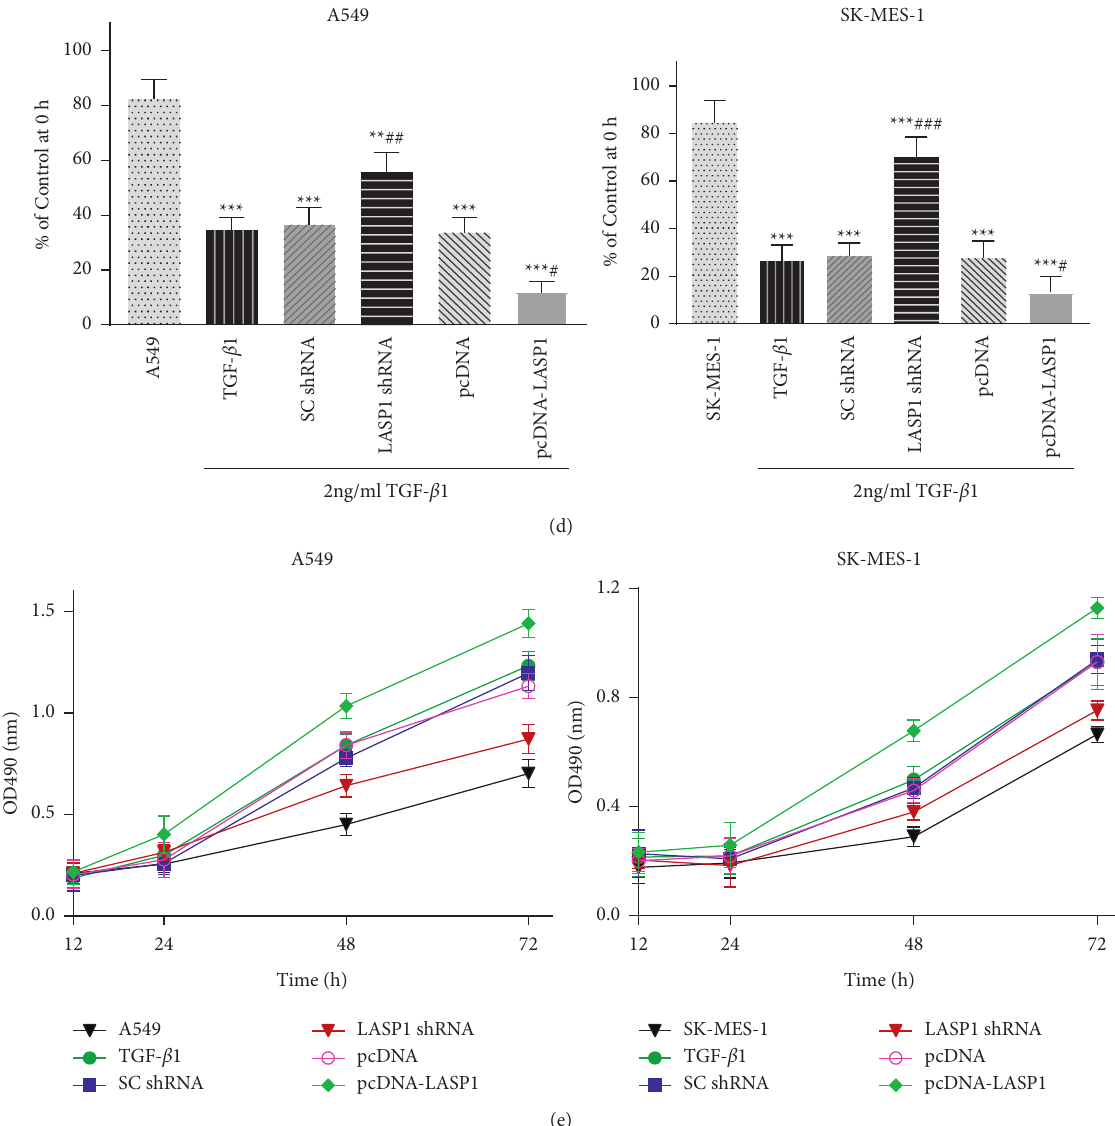
(h)0.00.51.01.5 D O Figure 3: (a–e) Effect of LASP1 on the pathological features of TGF- β 1-treated A549 and SK-MES-1. (a) The representative images of transwell assays showed the inhibitory or enhanced effect of LASP1 silence or overexpression under TGF- β 1-induced invasion, respectively. (b) The quantification showed the relative permeability compared to the cell alone group without TGF- β 1 treatment. (c) The representative images of wound healing assays showed the inhibitory or enhanced effect of LASP1 silence or overexpression under TGF- β 1-induced migration. (d) The quantification showed the relative migration. (e) LASP1 silence or overexpression had an inhibitory or enhanced effect on lung cancer cell’s proliferation until to 72h under TGF- β 1 treatment, respectively. Data were shown as mean ± SD, n � 3. ∗ p < 0 . 05, ∗∗ p < 0 . 01, and ∗∗∗ p < 0 . 001 vs. the cell alone group without TGF- β 1 treatment, and # p < 0 . 05, ## p < 0 . 01, and ### p < 0 . 001 vs. the TGF- β 1- treated noninfection group (TGF- β